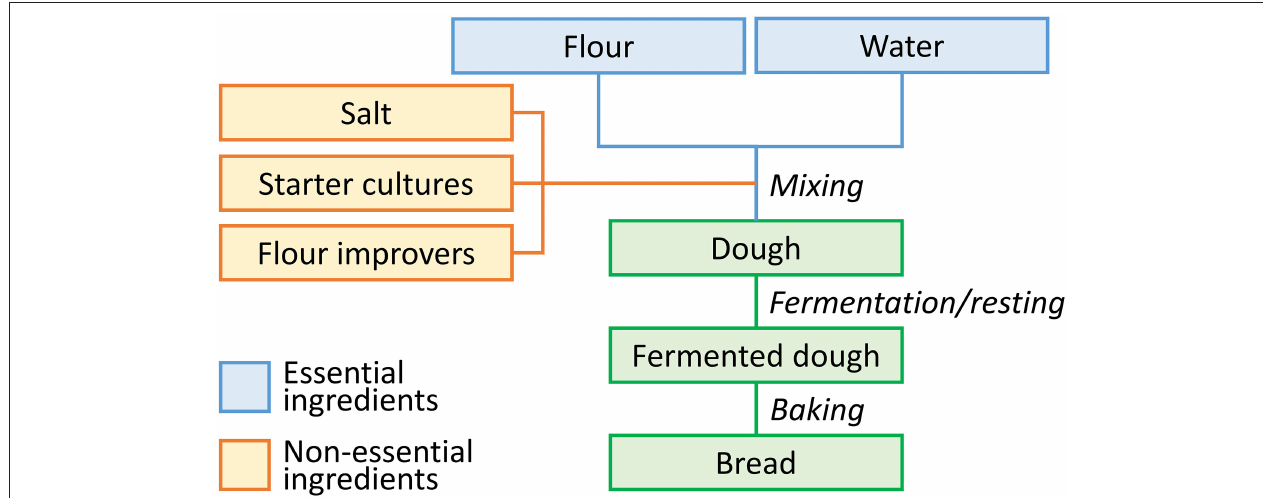
FIGURE 1 | Schematic representation of the bread-making process.